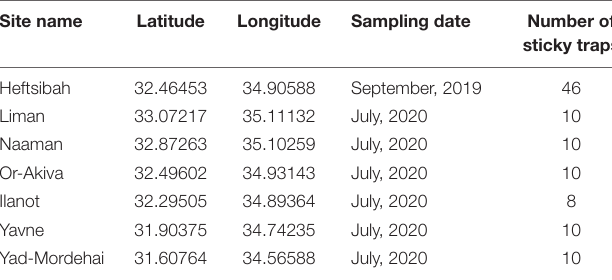
TABLE 1 | Locations, dates, and numbers of sticky traps analyzed for this